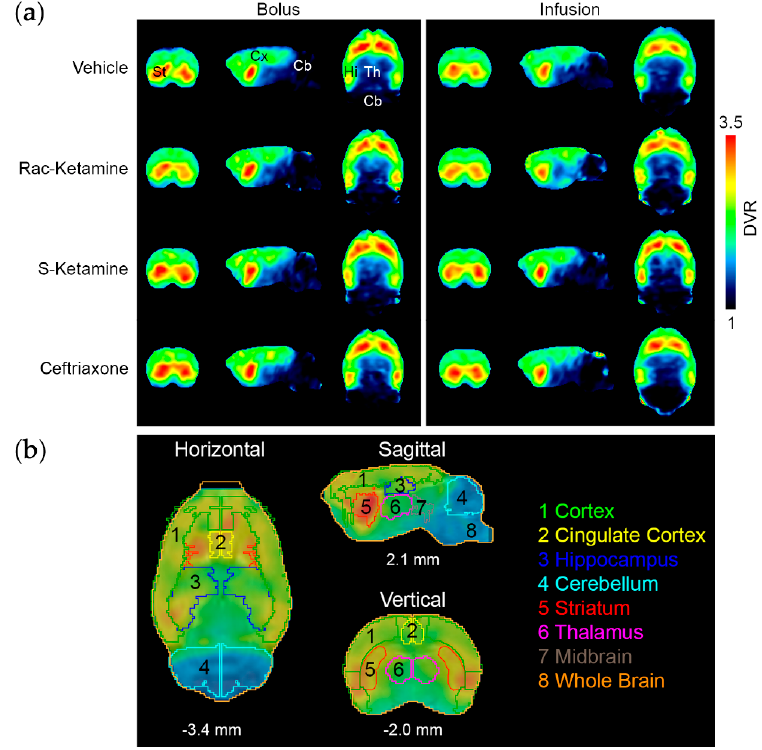
Figure 3. ( a ) illustration of averaged [ 18 F]PSS232 brain uptake as mGluR5 distribution volume ratios (DVRs) after vehicle (0.9% NaCl; n = 4), racemic ketamine ( n = 4), S-ketamine ( n = 4) and ceftriaxone ( n = 4) challenge. PET images were derived after bolus injection ( left ) or infusion ( right ) and presented in axial, sagittal and coronal planes. St, striatum; Cx, cortex; Cb, cerebellum; Hi, hippocampus; Th, thalamus; ( b ) definition of brain regions-of-interest on PET images in horizontal (coronal), sagittal and vertical (axial) sections. Locations in mm are distance to the Bregma. The quantitative regions-of-interest analysis is shown in Figure 2.